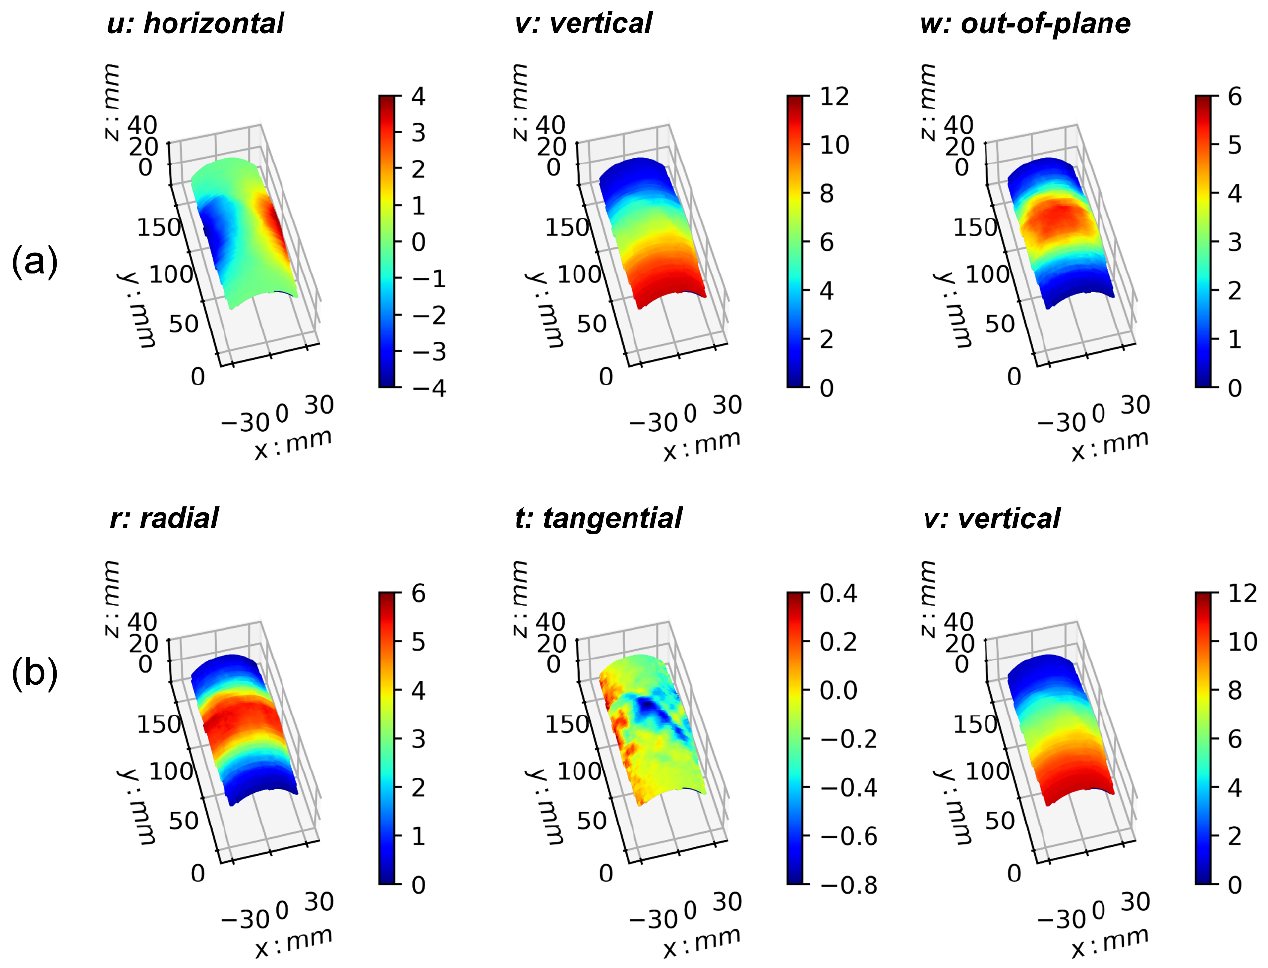
Figure 2. Example of 3D displacement field. Test 092903b at 7% of axial strain. ( a ) Displacement field projections of Cartesian components in horizontal, vertical, and out-of-plane directions (left to right). ( b ) Displacement field projections of cylindrical components in radial, tangential, and axial directions.